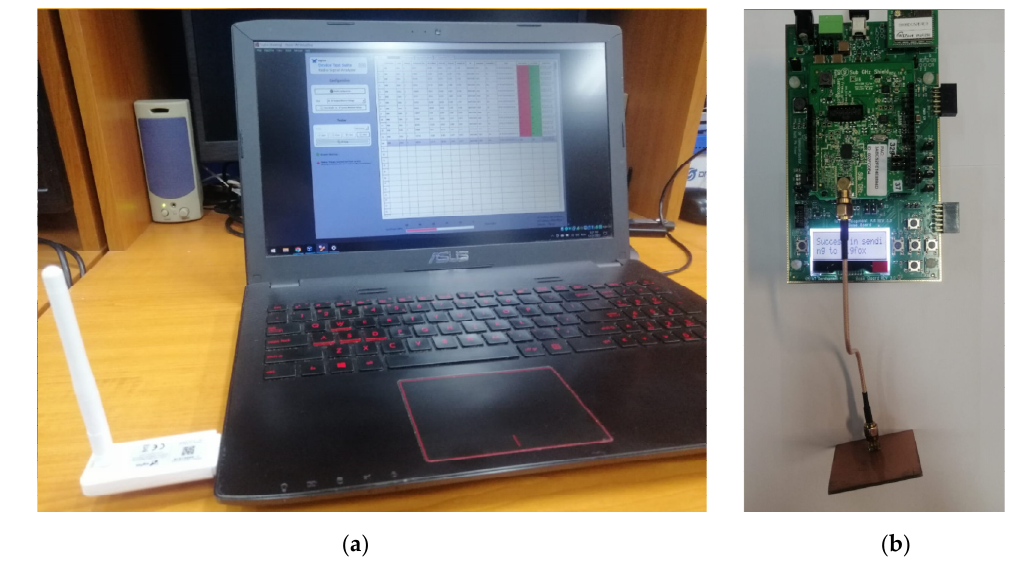
Figure 15. Real operating scenario test setup: ( a ) Sigfox SDR certification Kit with the SigFox Radio Signal Analyzer App; ( b ) ON Semiconductors Sigfox Development Kit with the proposed antenna attached.